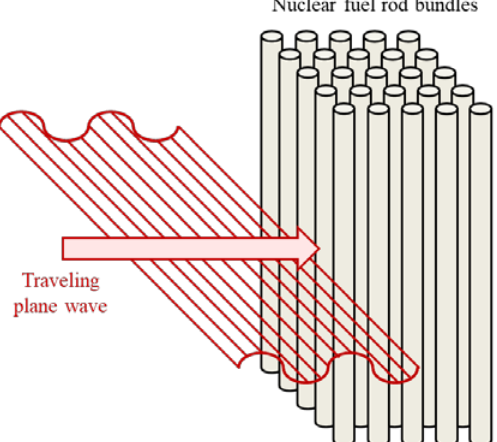
Figure 1. Flexural vibration of nuclear fuel rod bundles subjected to traveling plane wave caused by external collisions.